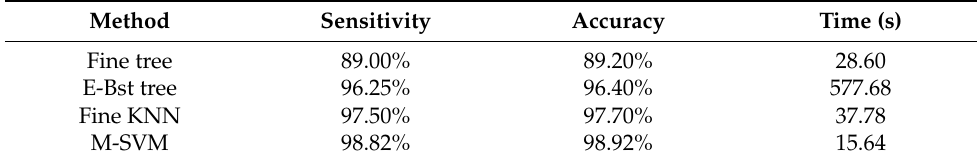
Table 10. MobileNetv2 based classification results for brain MRI